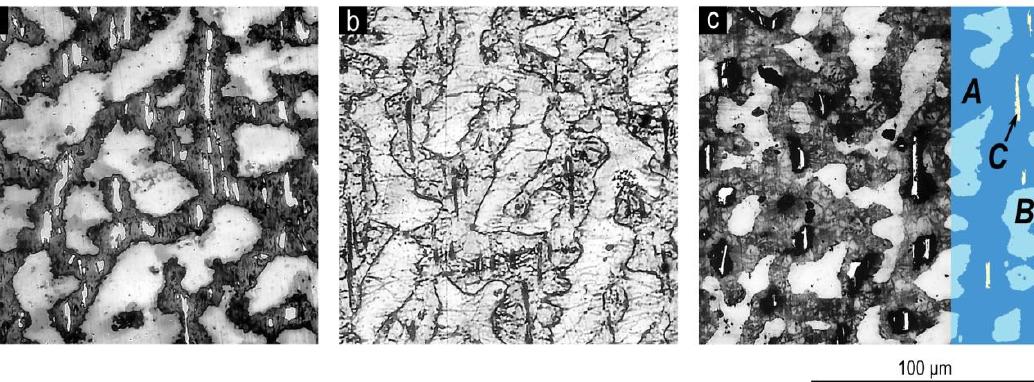
Figure 4. Microstructure on the prismatic plane of the pseudo-single crystal samples of the Sm 0.85 Zr 0.15 (Co 0.702 Cu 0.088 Fe 0.210 ) 6.4 alloy in the ( a ) as-cast state, ( b ) after solid-solution heat treatment, and ( c ) after complete cycle of heat treatment (optical microscope, etching with 5% alcohol solution of HNO 3 ). The easy magnetization axis is in the image plane and strictly horizontal. Definitions for structural components for A, B and C in ( c ) are given in the text.